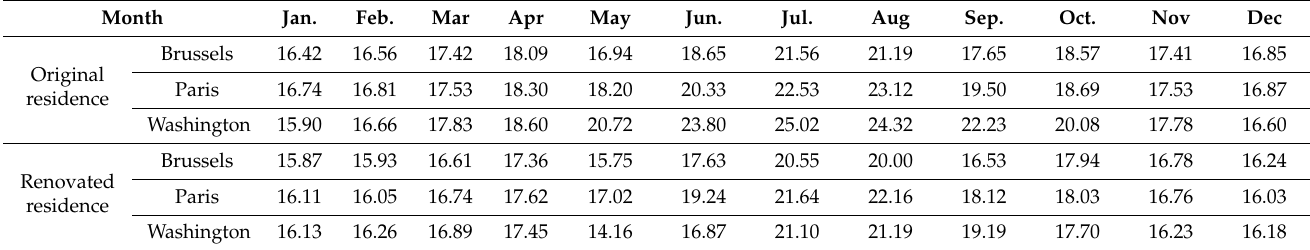
Table 10. Comparison of indoor air temperature (in ◦ C) in one residence building located in three cities. Month